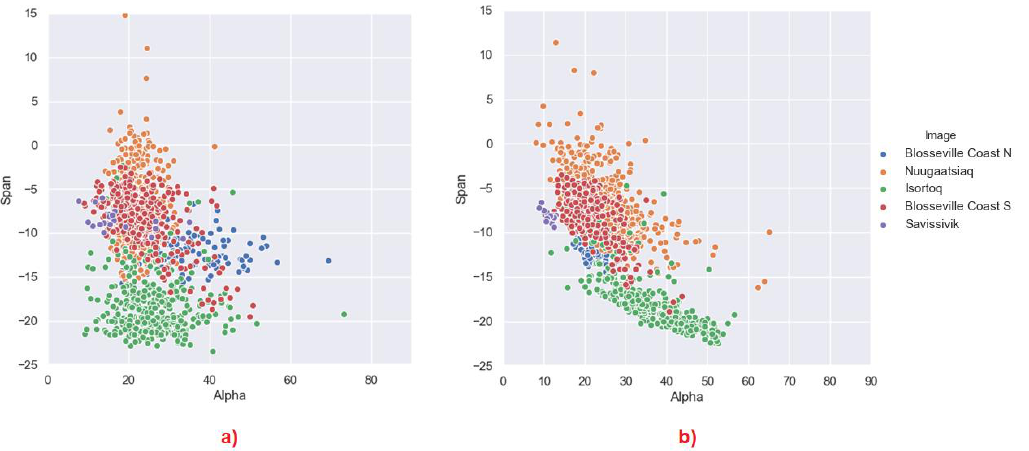
Figure 13. ( a ) Iceberg alpha, span plot 5 × 5 window, ( b ) 11 × 11 window. Colour legend indicates image. Dots indicate icebergs.